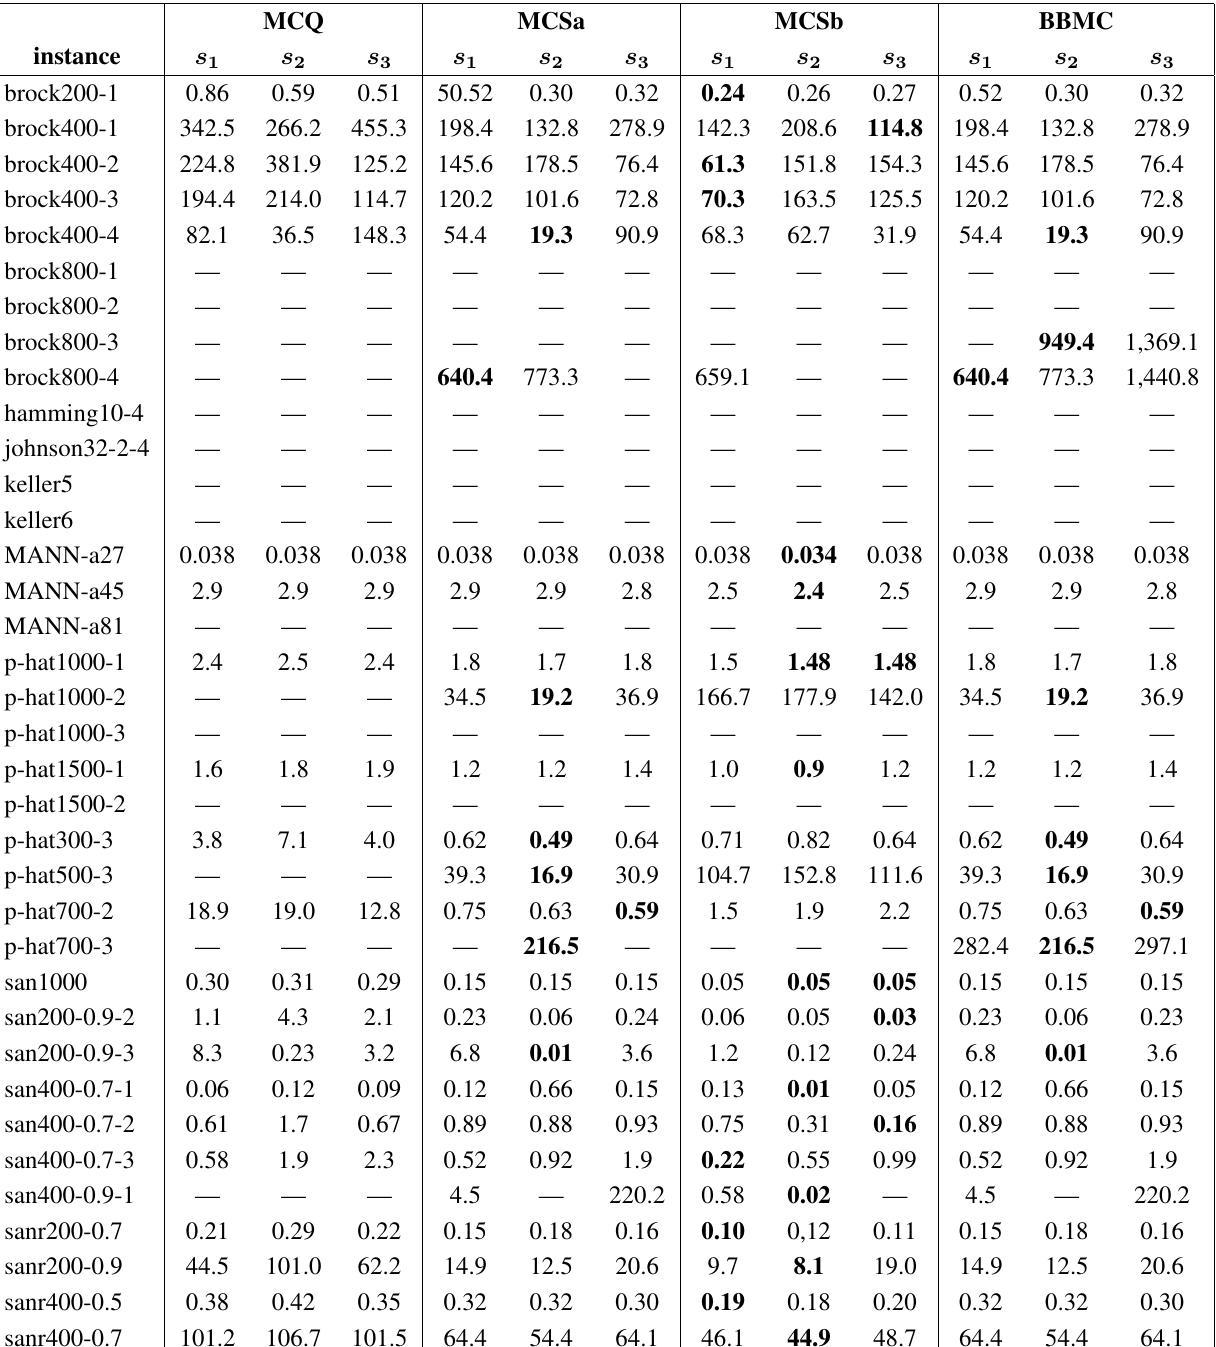
Table 4. DIMACS instances: The effect of style on search nodes in